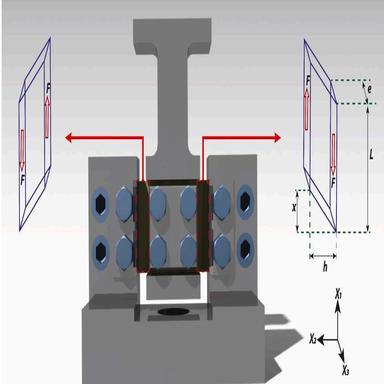
Definition of reference axes and deformed parallelepipedal in the shear jaw.